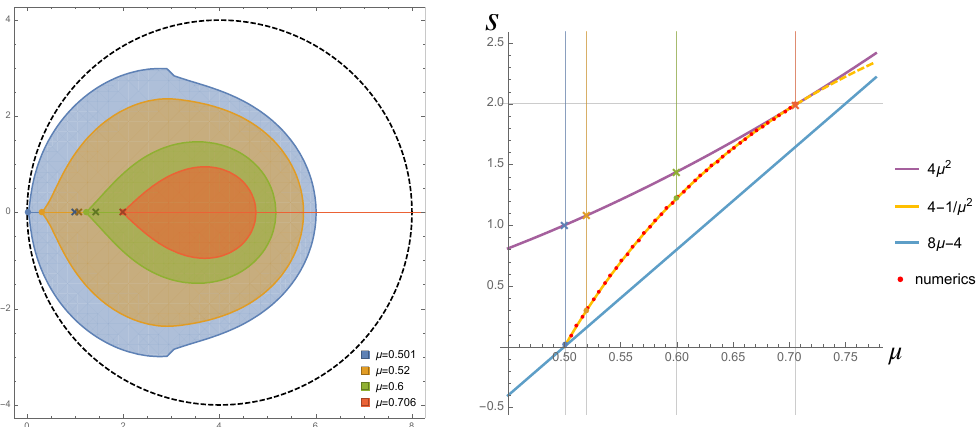
√ 2 / 2 .) The shaded regions are the ‘bad’ √ (cid:0) (cid:1) 1 / 2 , 1 / 2 ,